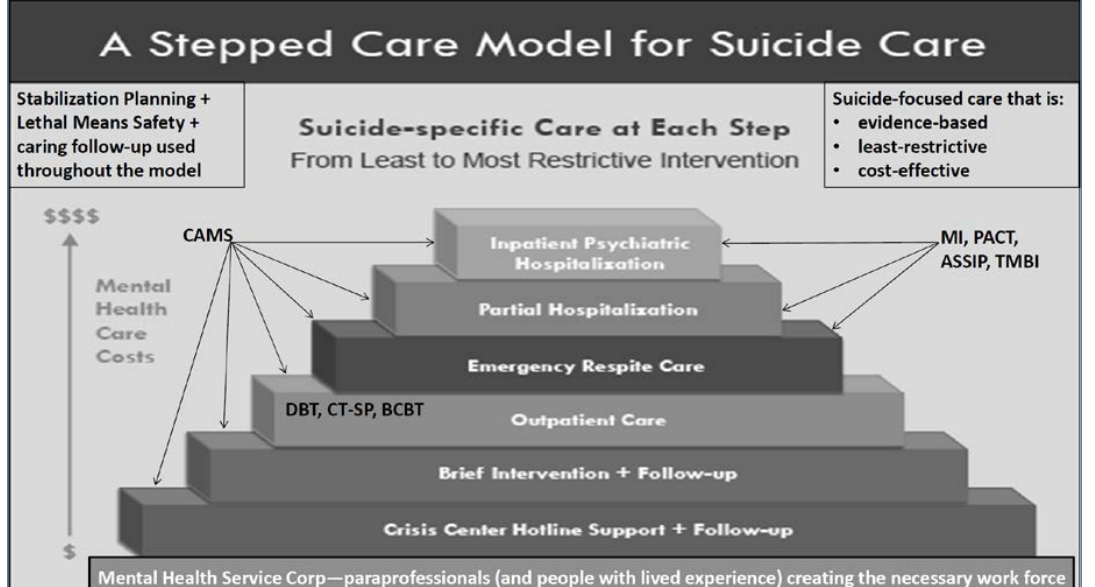
Figure 2. The y-axis is mental health care costs; the steps of the pyramid correspond from the bottom to the top with the least restrictive intervention the most restrictive intervention. ASSIP = Attempted Suicide Short Intervention Program; BCBT = Brief Cognitive Behavior Therapy; CAMS = Collaborative Assessment and Management of Suicidality; CT-SP = Cognitive Therapy for Suicide Prevention; DBT = Dialectical Behavior Therapy; MI = Motivational Interviewing; PACT = Post Admission Cognitive Therapy; TMBI = Teachable Moment Brief Intervention.